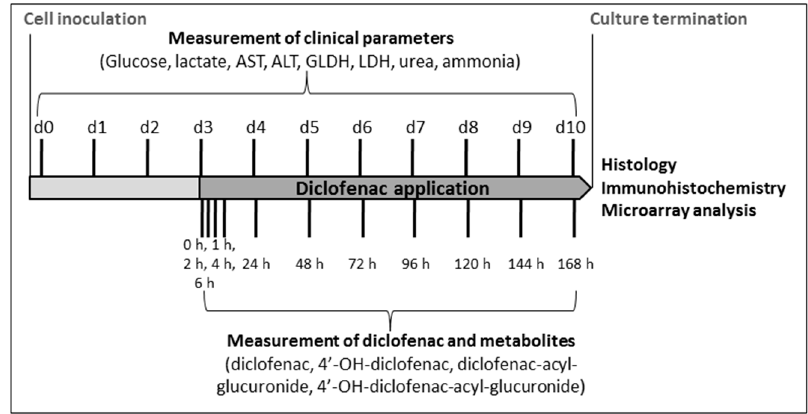
Figure 3. Experimental design. Overview of the time schedule of drug application and sampling in bioreactors run with primary human liver cells.